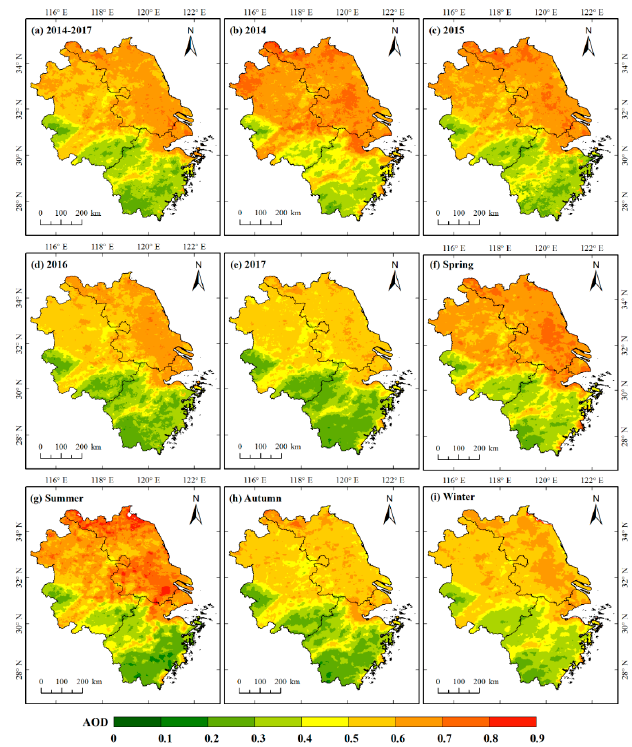
Figure 6 . The spatial distribution of (a) four-year average AOD, (b–e) annual average AOD, and (f–i) Figure 6. The spatial distribution of ( a ) four-year average AOD, ( b – e ) annual average AOD, seasonal average AOD over the PYRD from 2014–2017. and ( f – i ) seasonal average AOD over the PYRD from